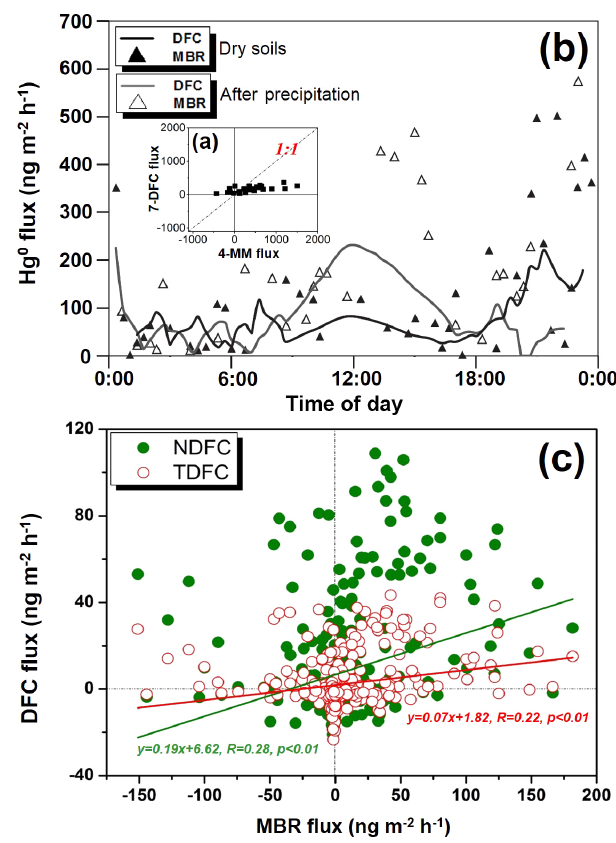
Figure 2. Field-collocated DFCs and MM techniques observed fluxes from two intercomparison studies. (a) Inlaid scatter plot of averaged 4-MM flux vs. averaged 7-DFC flux (TOT: 1.1–24min) in Hg-enriched Nevada STORMS site in September 1997 (Gustin et al., 1999); (b) Diel evolution of Hg 0 flux measured using a 1L polycarbonate-DFC (TOT: 0.2min) and MBR method at same Nevada STORMS site in October 1998 (Gustin, 2011); (b) Scatter plot of DFC with traditional/novel designs (TDFC/NDFC) vs. MBR Hg 0 flux obtained in Yucheng intercomparison project (Zhu et al.,